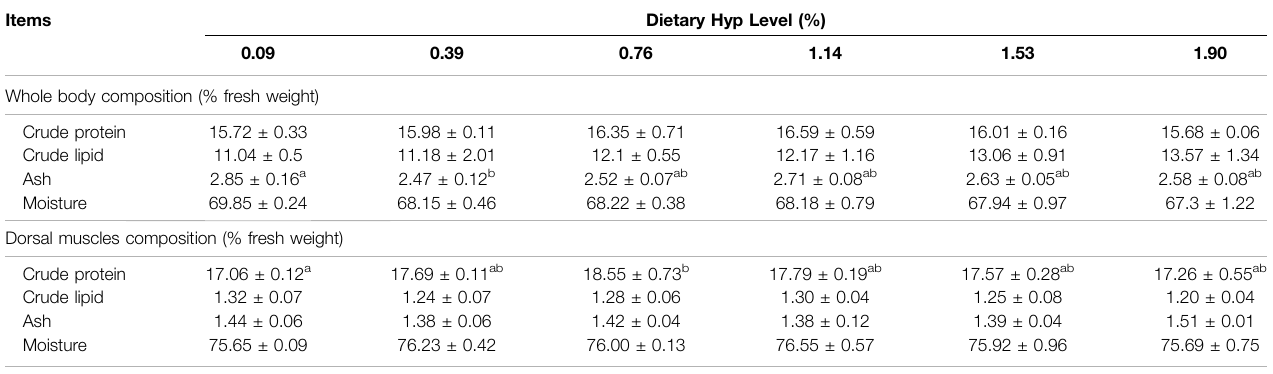
TABLE 5 | Whole body and dorsal muscle compositions of ITCC fed with different experimental diets for 8 weeks. Items